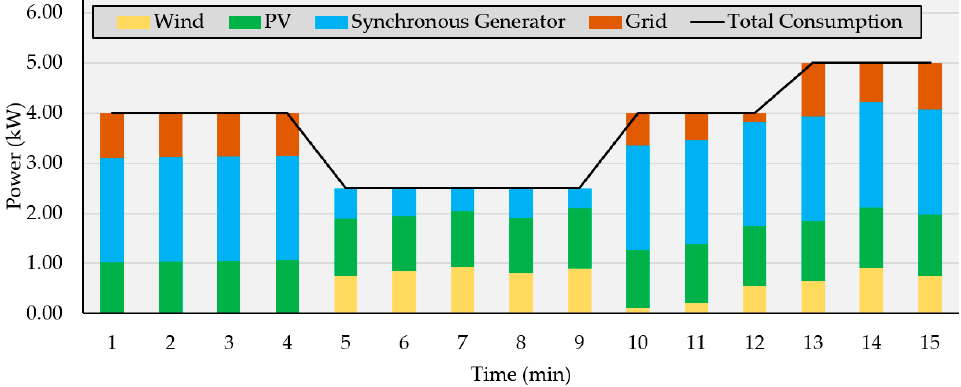
Figure 5. Energy scheduling results adapted from the algorithm for a period of 15 min.